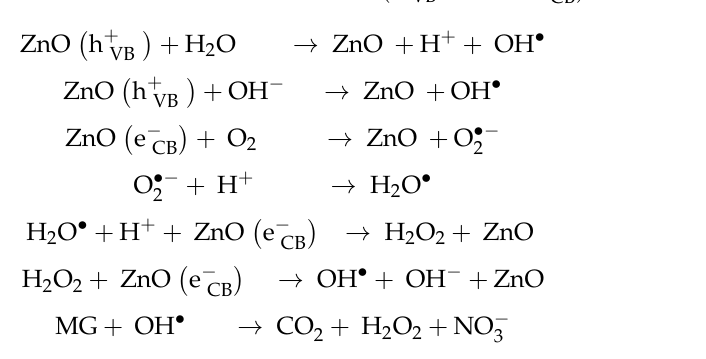
Figure 7. Effect of bubbling of N 2 and O 2 purging.